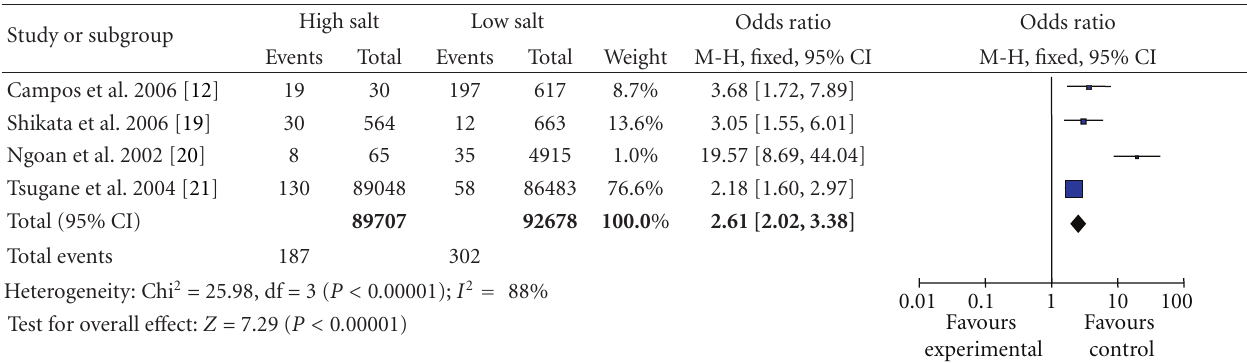
Table 6: High versus low categories of salt and gastric cancer in Japan.